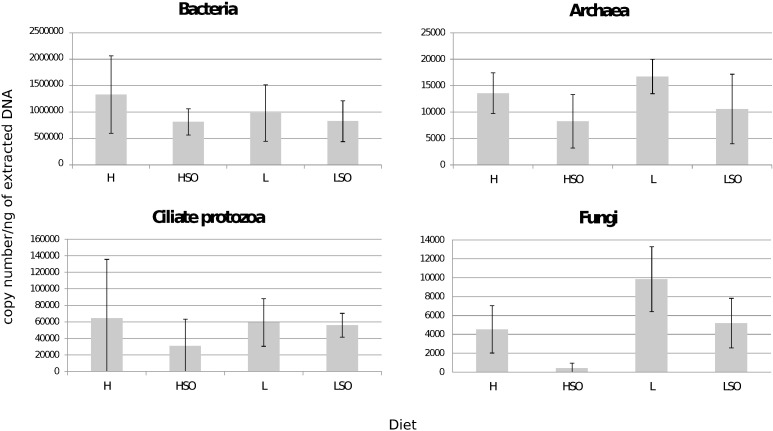
qPCR of bacterial 16S rRNA, archaeal mcrA, protozoal 18S rRNA genes and fungal region between 18S rRNA and ITS1 of rumen digesta samples.Samples collected from lactating cows fed four diets: high (H) or low (L) proportion of concentrates without oil, or supplemented with SO (HSO and LSO, respectively). Results are expressed as copy number per ng of extracted DNA. Error bars represent standard deviations (SD), n = 4 per diet.